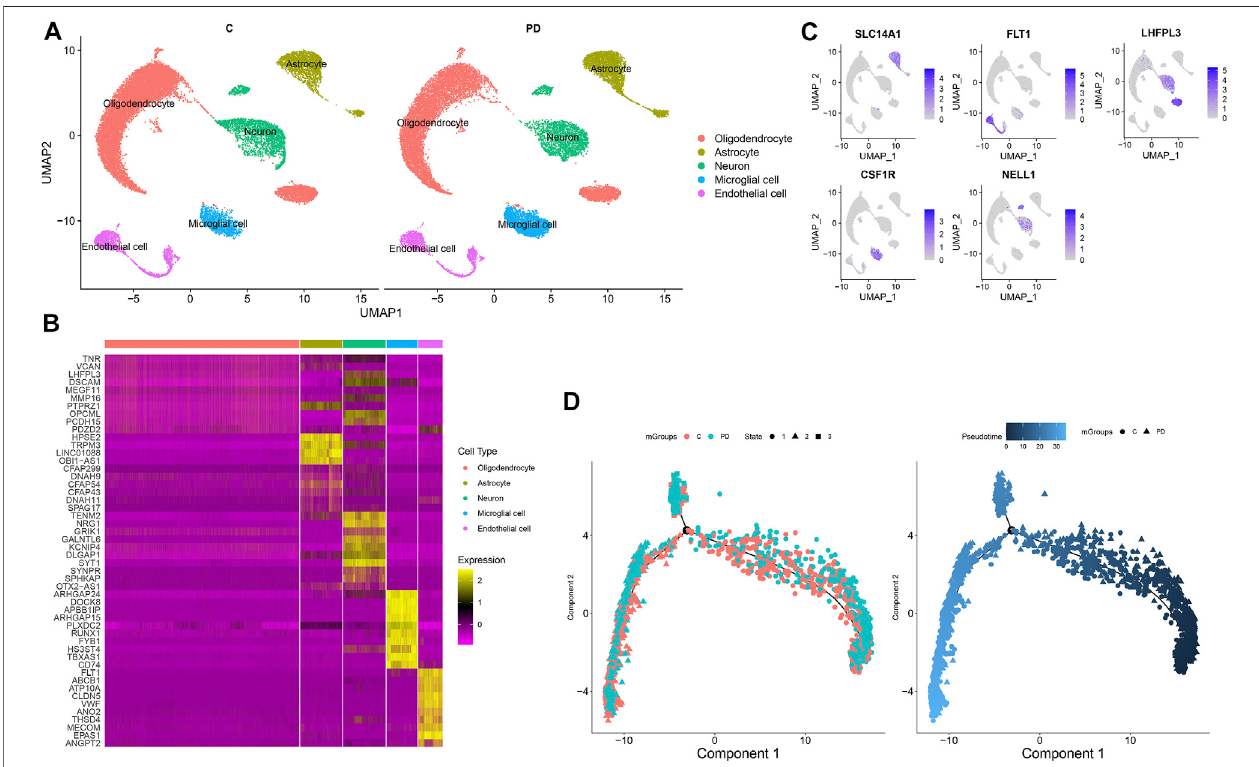
FIGURE 3 | Identi fi cation of cell clusters for PD. (A) Cell clusters with the UMAP method. (B) Heat map for the top 10 marker genes for each cluster. (C) Feature genes for each cluster. (D) Pseudotime analysis of endothelial cells in PD and healthy samples. Each point represents a single cell.